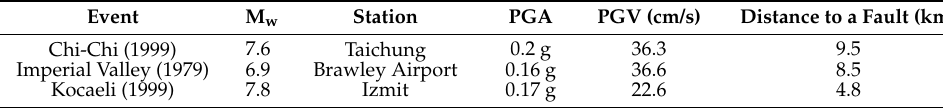
Table 4. Near-fault earthquake time histories.